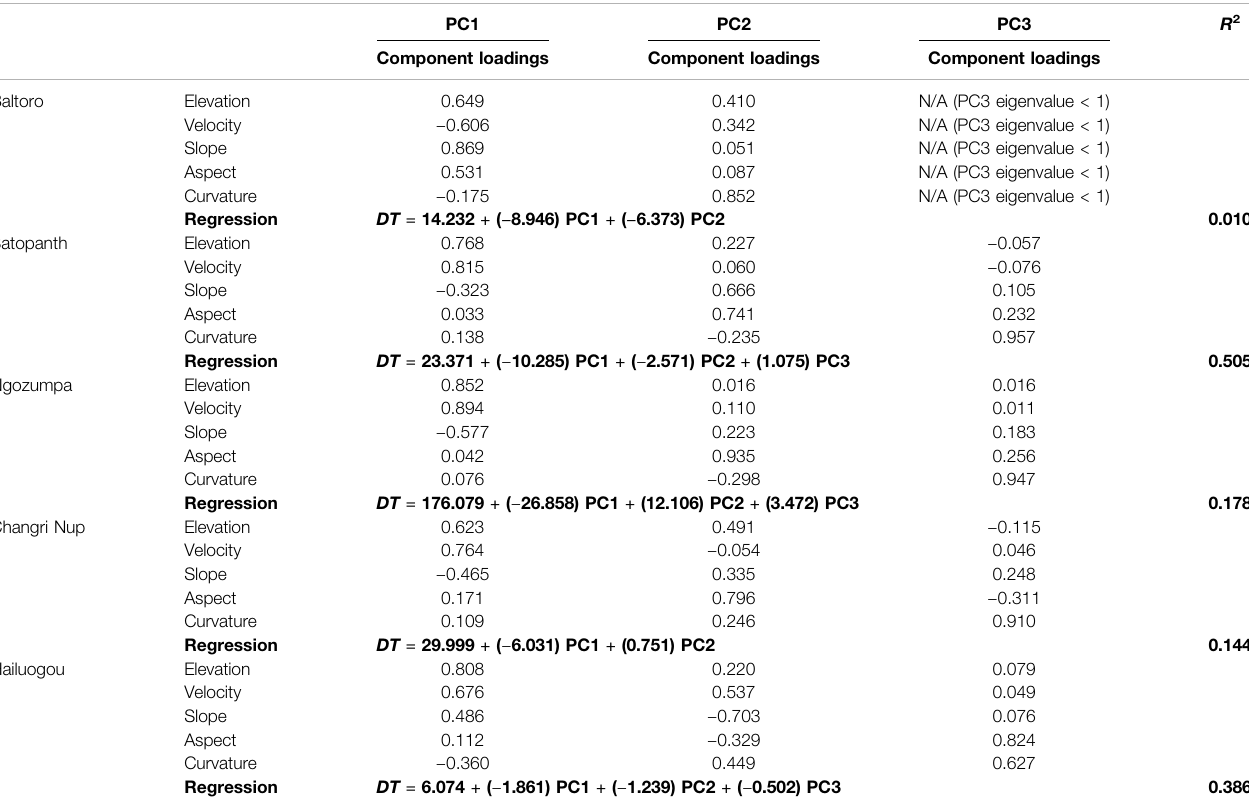
TABLE5| ComponentloadingsofthePrincipalComponents(PCs)withaneigenvalueequaltoorgreaterthan1,andtheregressionequationsand R 2 values(bold)ofdebris thickness ( DT ) with PCs as independent variables, for each